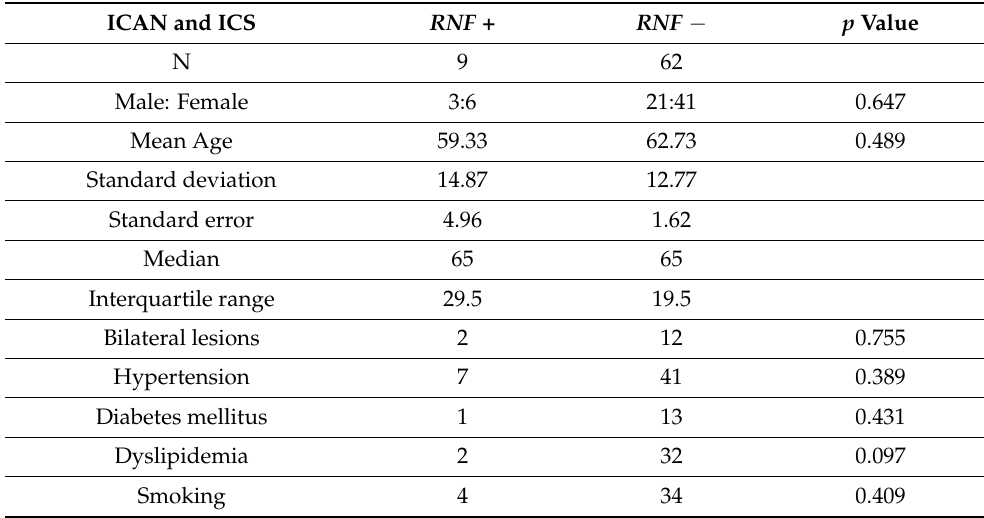
Table 2. Characteristics of cases with and without RNF213 c.14576G>A.